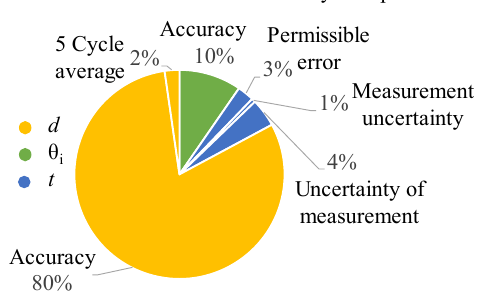
Fig. 3. Uncertainty budget of the built system and every contribution the measurements uncertainty by the three main parameters d , θ i and t .